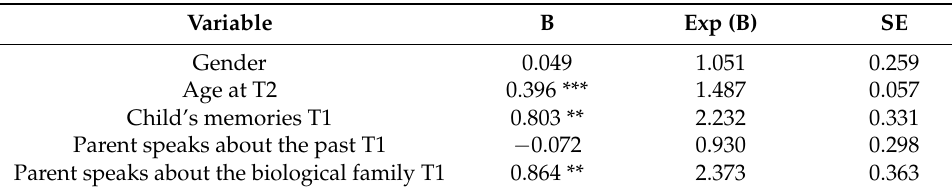
Table 5. Multivariate logistic regression of ‘child speaks about the biological family’ (0 = “yes”; 1 =